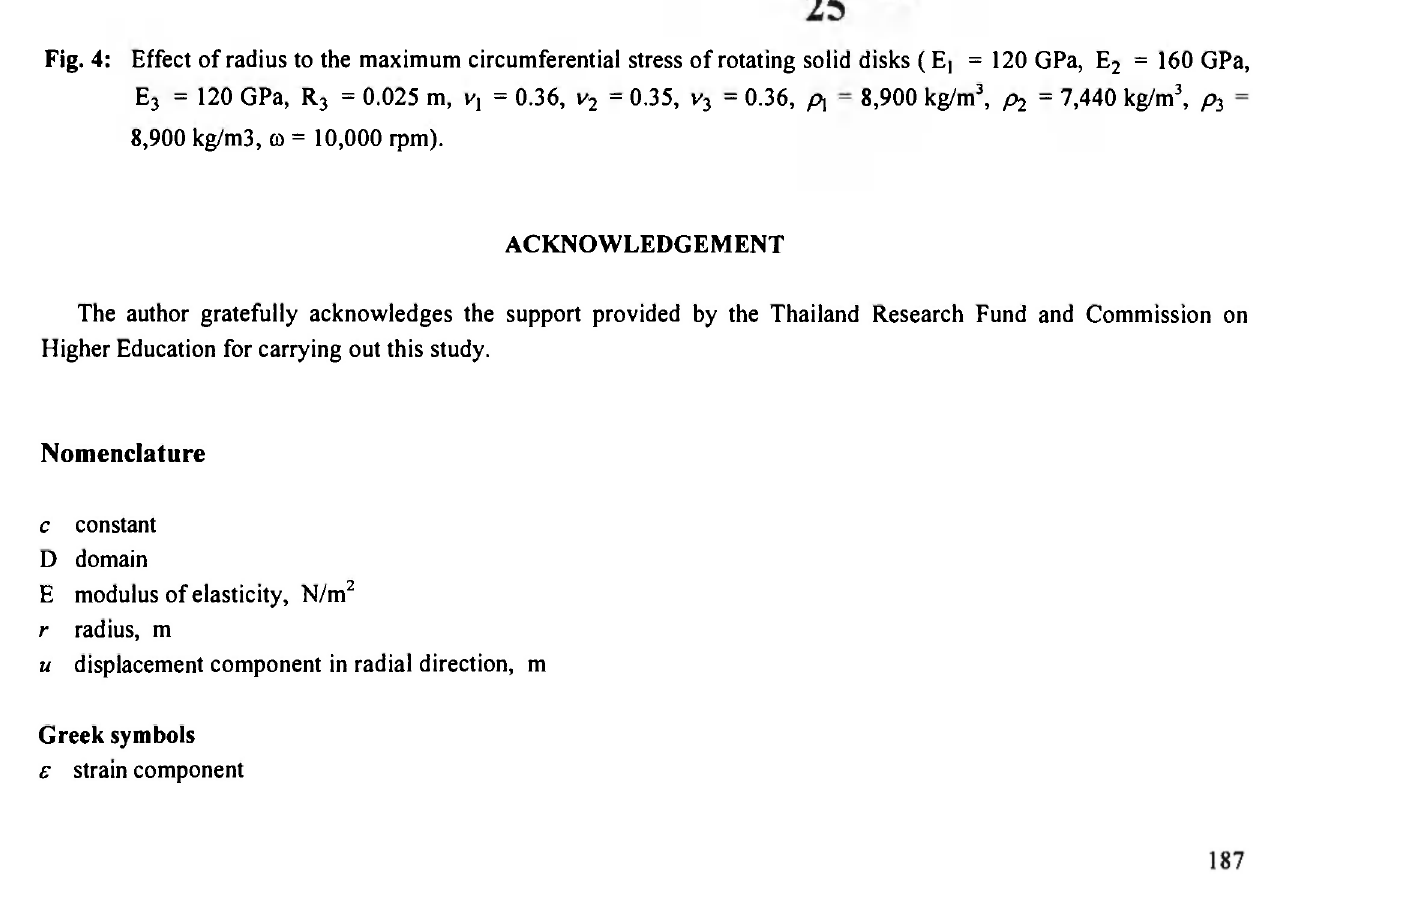
Fig. 4: Effect of radius to the maximum circumferential stress of rotating solid disks (E, =120 GPa, E 2 =160 GPa, E 3 = 120 GPa, R 3 = 0.025 m, Vi = 0.36, v 2 = 0.35, v 3 = 0.36, p, 8,900 kg/m3, ω = 10,000